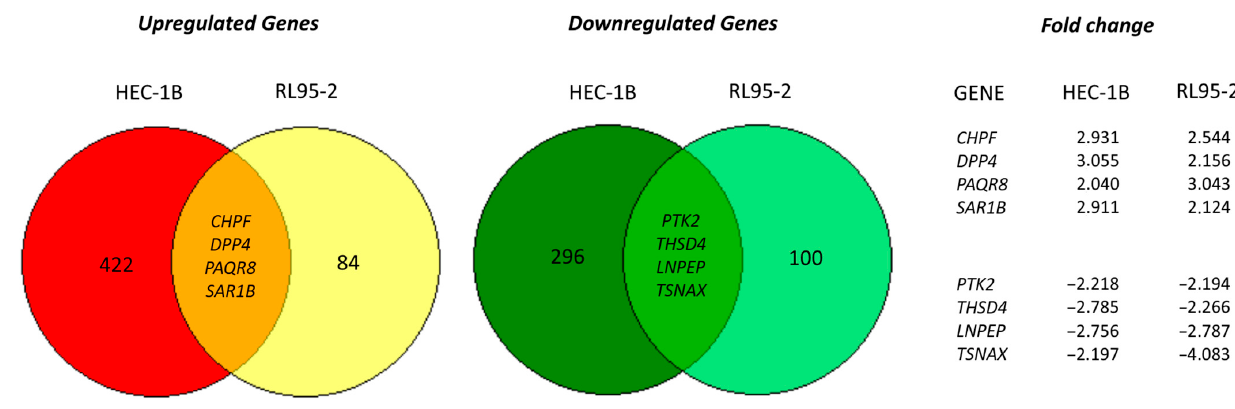
Figure 3. Venn diagram of the genes up- or downregulated upon DSCAM-AS1 silencing in HEC-1B and RL95-2 cells, with the overlapping regions indicating genes with equidirectional regulation in both cell lines. (Cut-off value: 2-fold change vs. control siRNA).